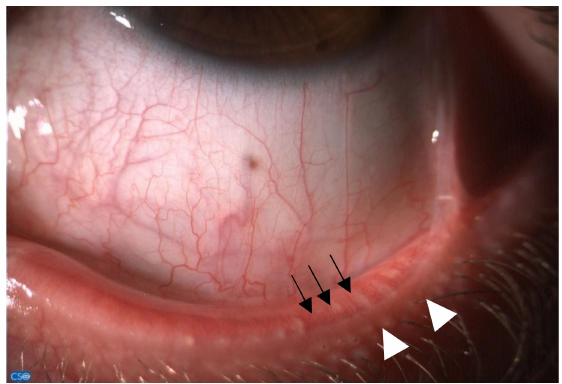
Figure 1. Dysfunction of the meibomian glands (white arrowheads) and telangiectasia (black arrows) on the edge of the lower